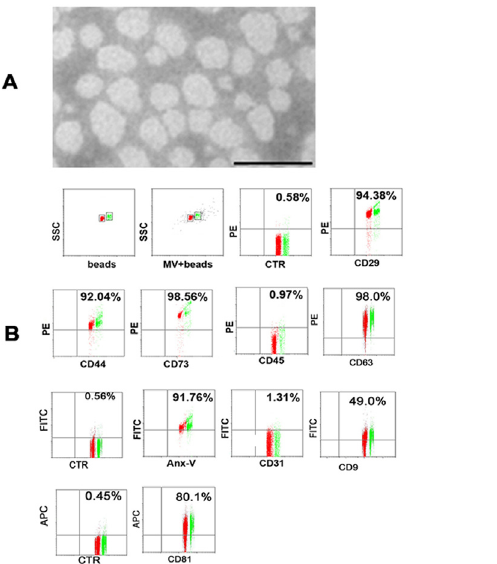
Fig 1. Identification of MSC-MVs with electron microscopy (A) and flow cytometry (B). (A) The bar represents 100nm. (B) MSC-MVs were conjugated with aldehyde/sulfate latex beads and reacted with fluorescein-labeled antibodies or Anx-V. The events were collected with a flow cytometer and the single beads (red) and the doublets of beads (green) were gated for further analysis. The percentages of the positivity in contrast to an isotype antibody are indicated. X-axis: forward scatter corner signals showing the size of the gated events. Beads: Beads were collected for the determination of the gates. Beads+MVs: MVs conjugated with beads were collected for further determination of the gates for analysis. CTR: MVs reacted with a PE-labeled isotype antibody. The results are representative of three individual experiments.